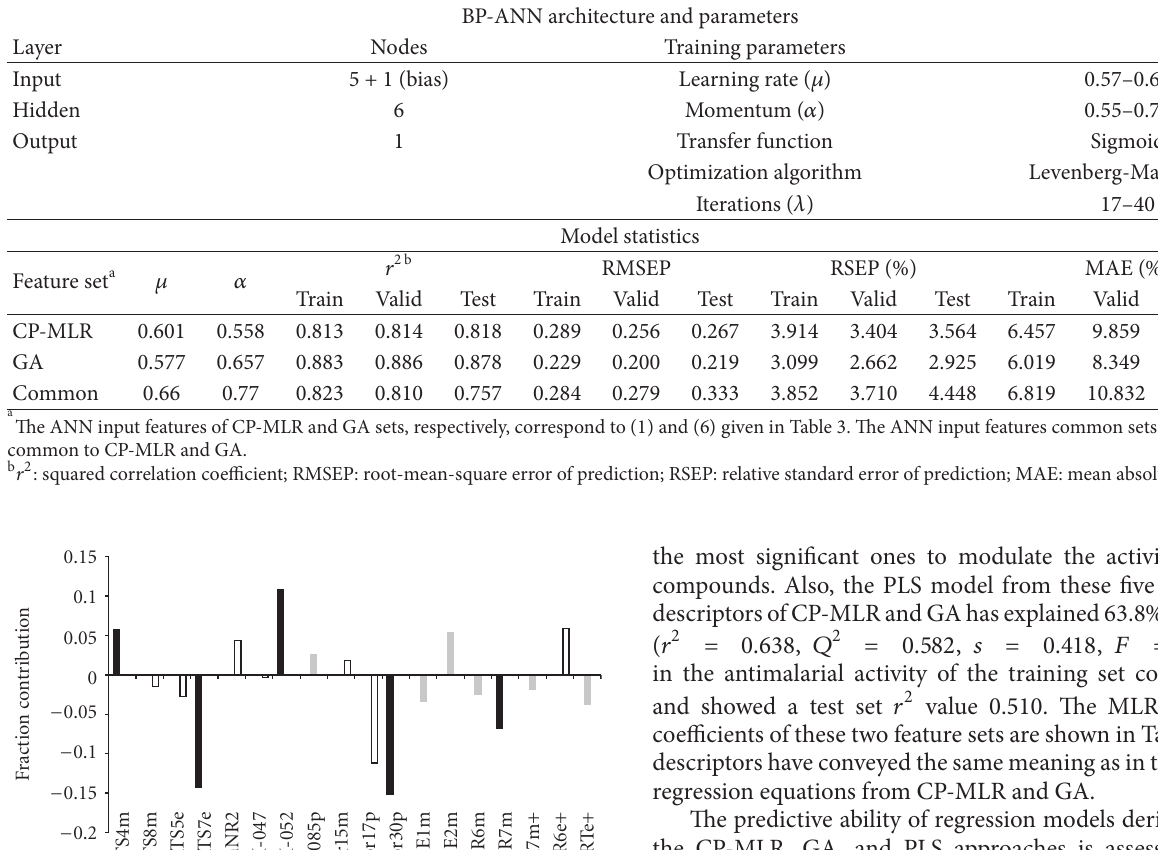
T 6: Architecture and goodness of �t of BP-ANN models for antimalarial activity of anilinoquinolines (Table 2) from selected feature sets of CP-MLR, GA, and their common �ve descriptors.